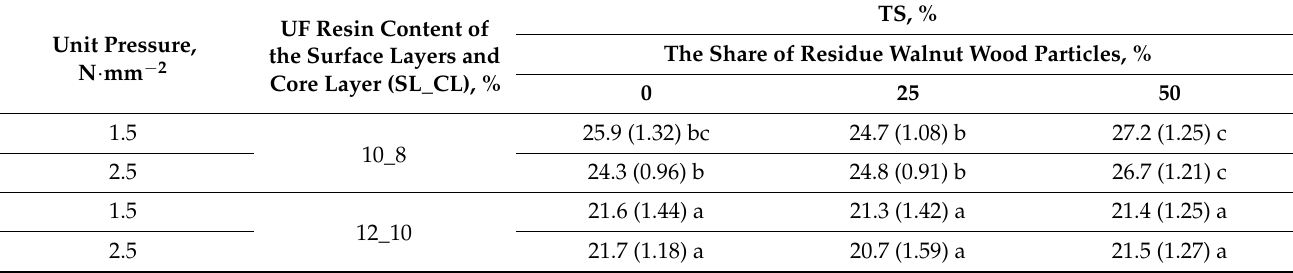
Figure 3. Internal bond (IB) of particleboards produced. Table 4. Results of the TS (24 h) of the particleboards produced.